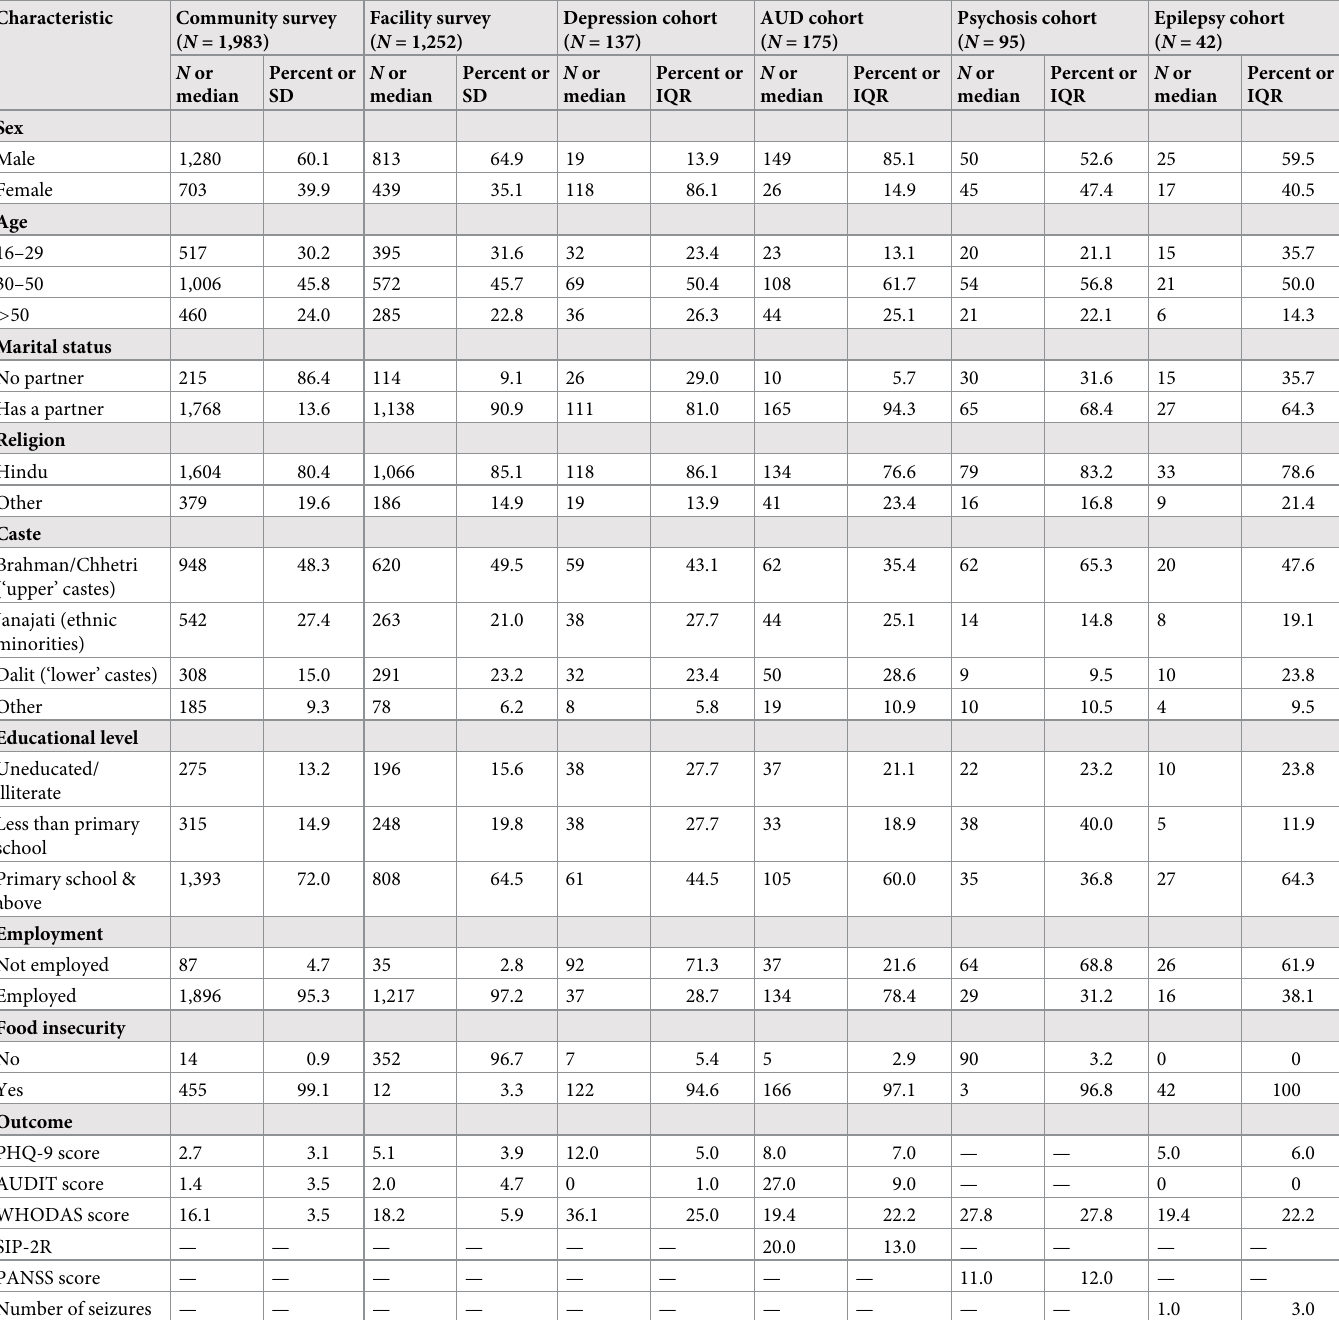
Table 3. Baseline demographic and clinical characteristics of the community surveys, facility surveys, and cohort samples.